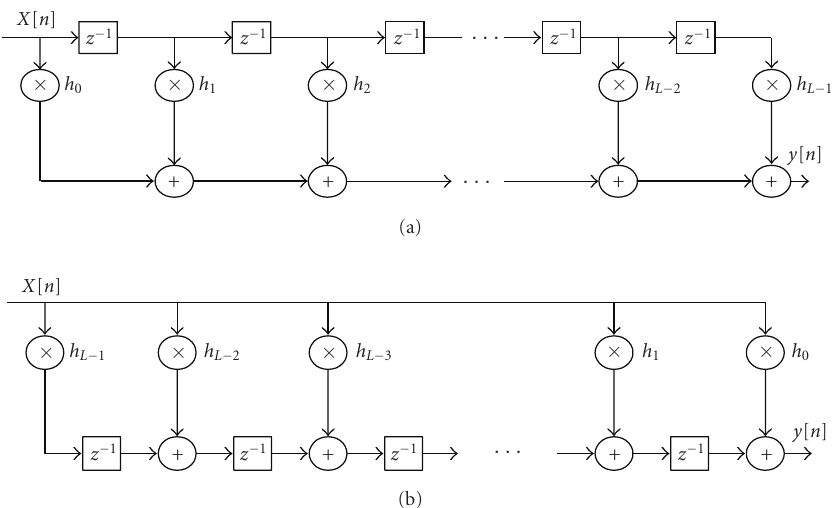
Figure 1: Mathematically identical MAC FIR filter structures: (a) The direct form of a finite impulse response (FIR) filter (b) The transposed direct form of an FIR